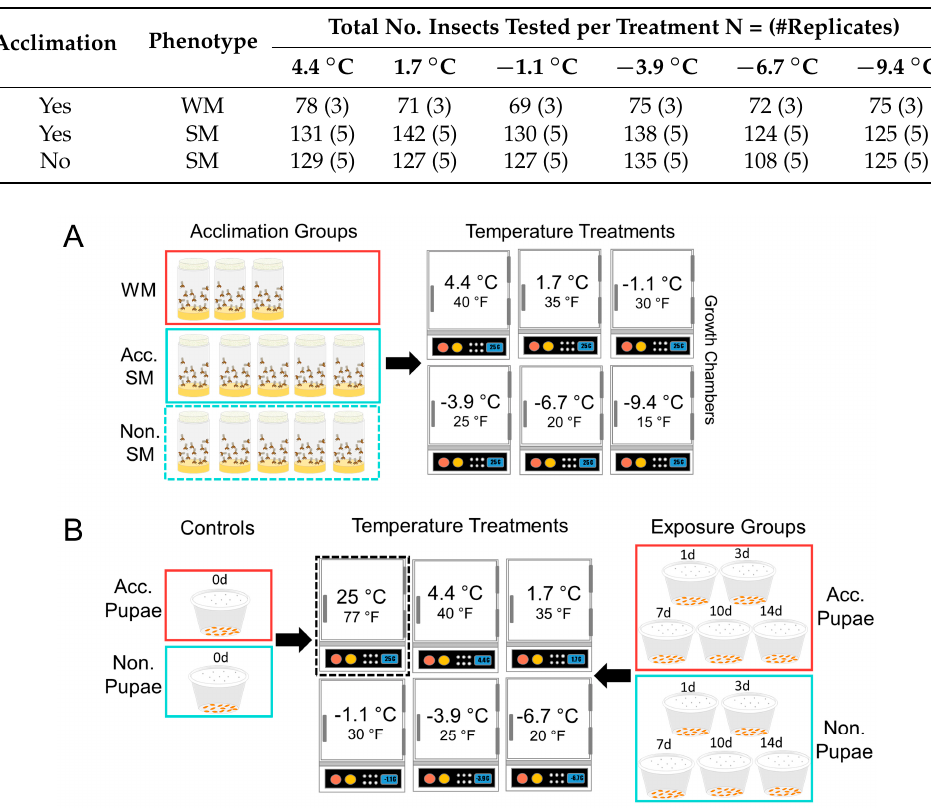
Table 1. Sample sizes and replicate structure for each adult static acclimation treatment group.